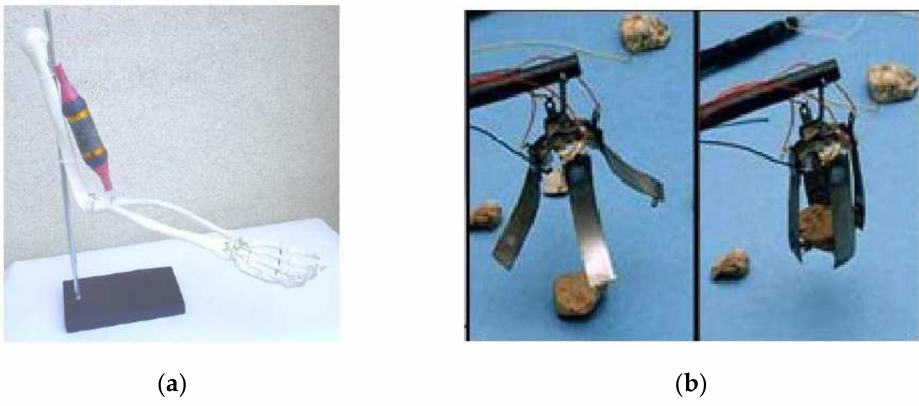
Figure 11. ( a ) The dielectric elastomer bionic skeletal muscle experiment; ( b ) IPMC bionic gripper [72,73].